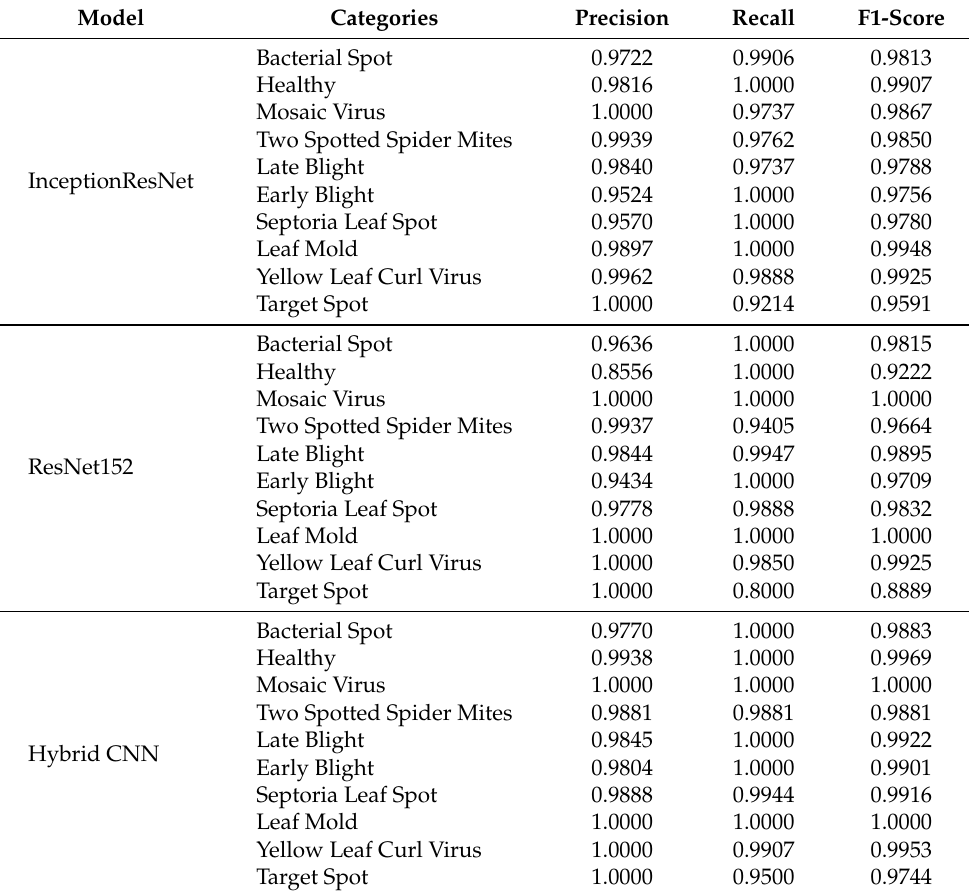
Table 6. Performance evaluation of three